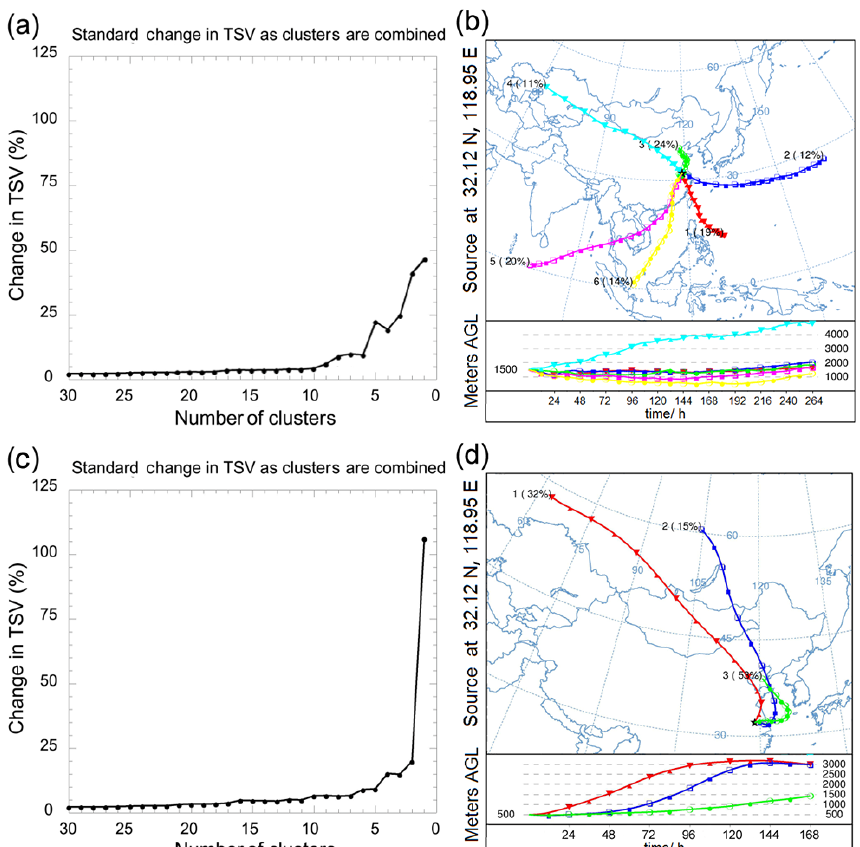
Figure 2. Change in TSV (total spatial variance) as clusters combined (left) and spatial distribution of vapor trajectories (right) for all precipitation events at Nanjing from September 2011 to November 2014: (a) and (b) are for the summer monsoon season (June–September), (c) and (d) are for the non-monsoon season (October–May). The vapor trajectories were simulated by the Hybrid Single-Particle Lagrangian Integrated Trajectory model (HYSPLIT). Vapor trajectories back to 11 days at 1500ma.g.l. (above ground level) were calculated for the summer monsoon season as water vapor transport is usually concentrated in the middle and lower troposphere (Bershaw et al., 2012). The moisture transport paths back to 7 days at 500ma.g.l. were determined for the non-monsoon season because of higher wind speed and lower condensation height in the non-monsoon season. The TSV was used to identify the optimum number of